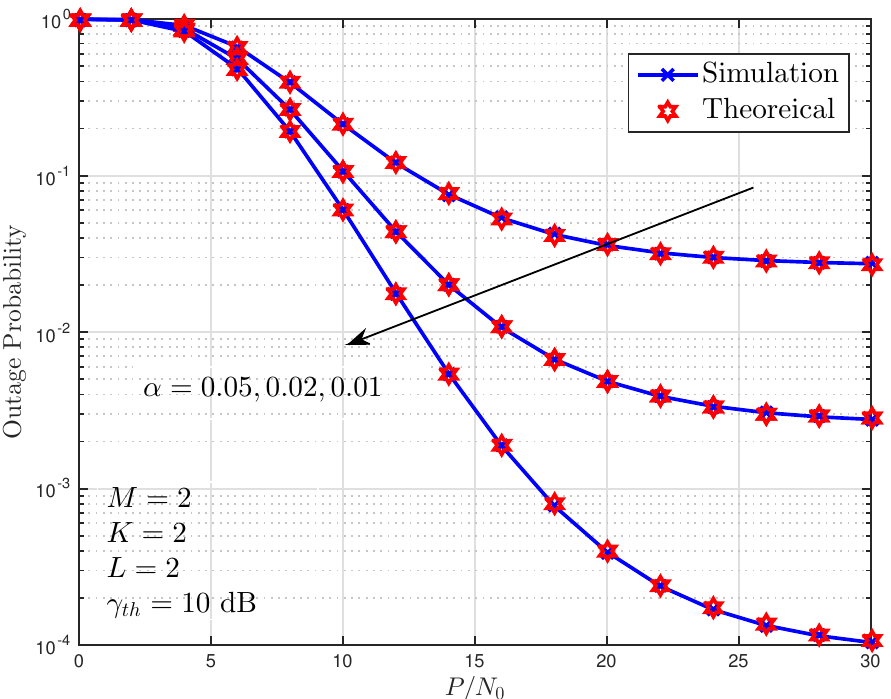
Figure 5. Outage probability of the secondary network versus P / N 0 for various interference leakage